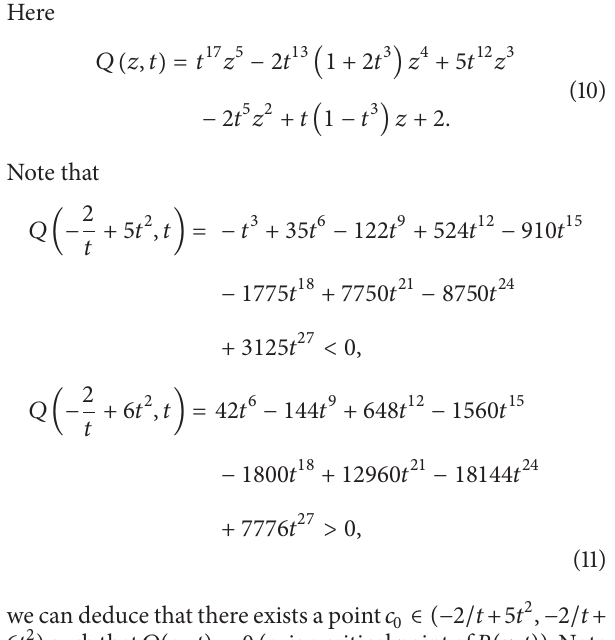
̃𝑅(𝑧,1/20) with connectivities 3, 5, and 9, respectively.